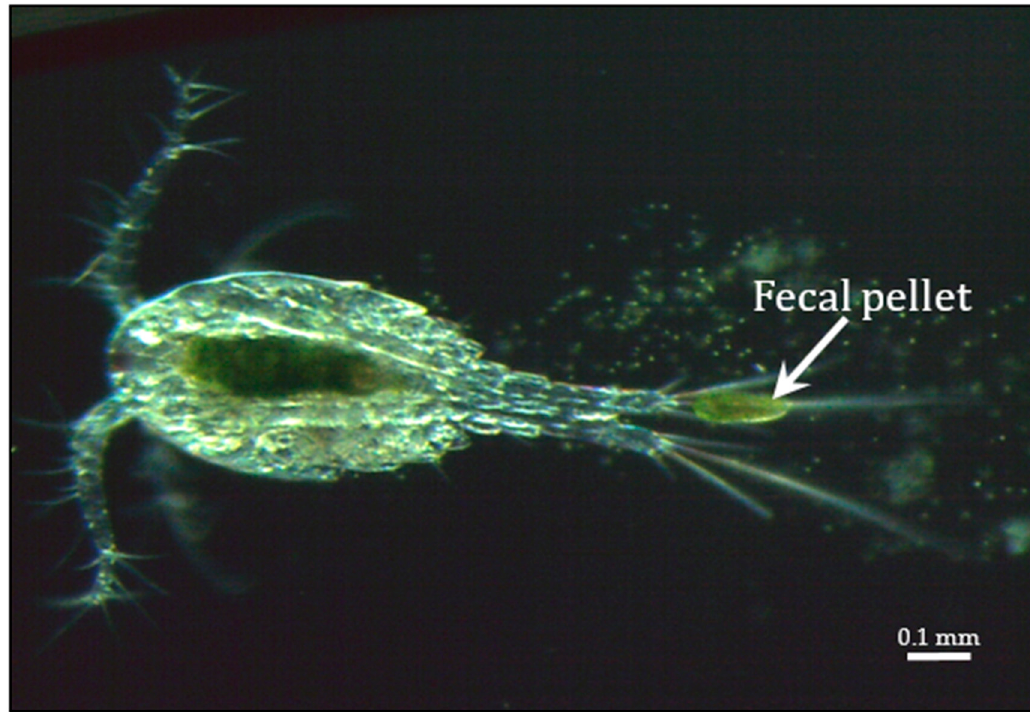
Figure 12. A copepod ( Eucyclops agilis ) gut full of disrupted Paramecia bursaria after foraging on the green paramecia and shown releasing a green fecal pellet. Incubating an isolated fecal pellet for 12 h resulted in an ~500-fold increase in chlorovirus titers.